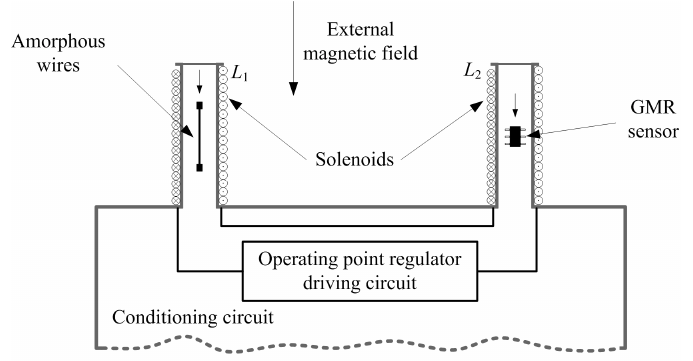
Figure 1. The structure of magnetic detector.